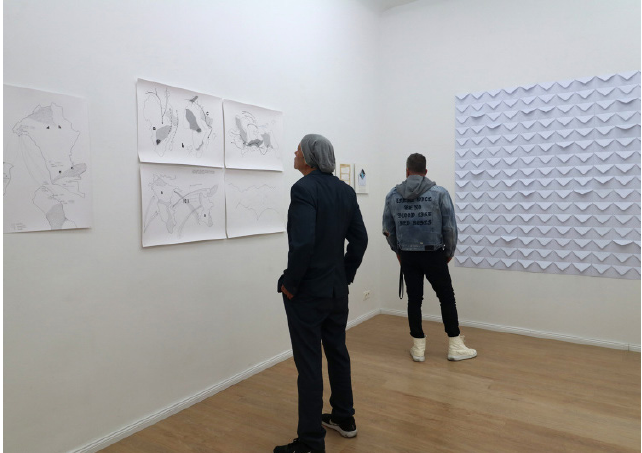
Figure 2 Melanye